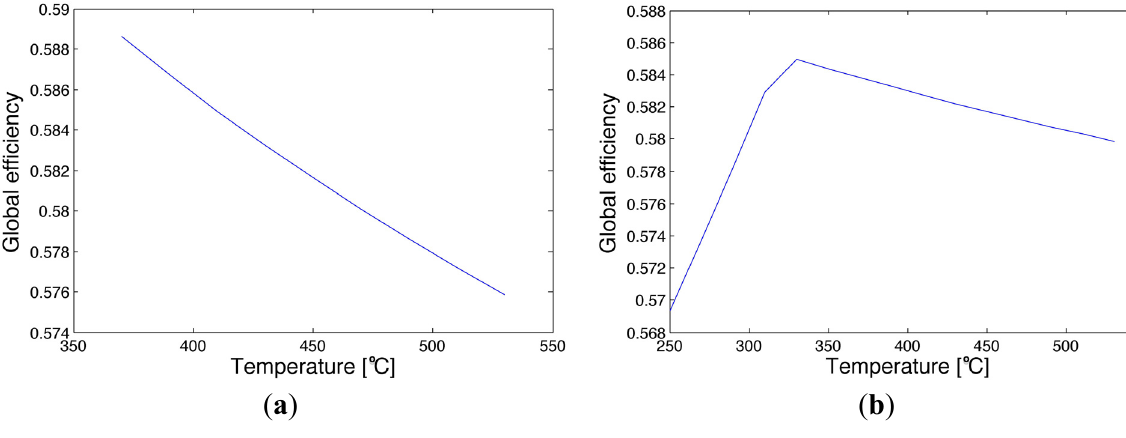
Figure 9. Effect of Boiler C tempering temperature on global